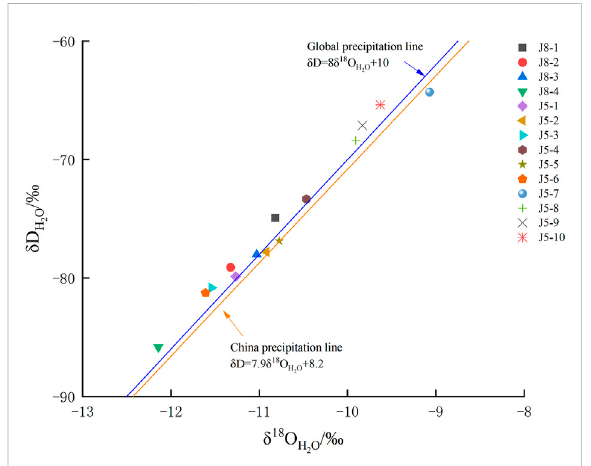
FIGURE 2 Relationship between δ D(H 2 O) and δ 18 O(H 2 O) of coalbed- producedwaterintheLinfenminingarea(modi fi edfromBaoetal., 2021).